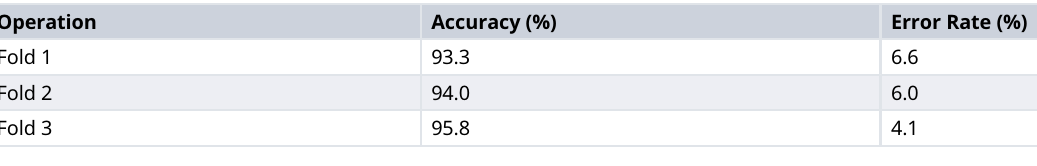
Table 2. Device's response times. The response times include query preparation, request delivery, and processing with the ventilator connected to a residential network with 20.14 and 12.23 Mbps download and